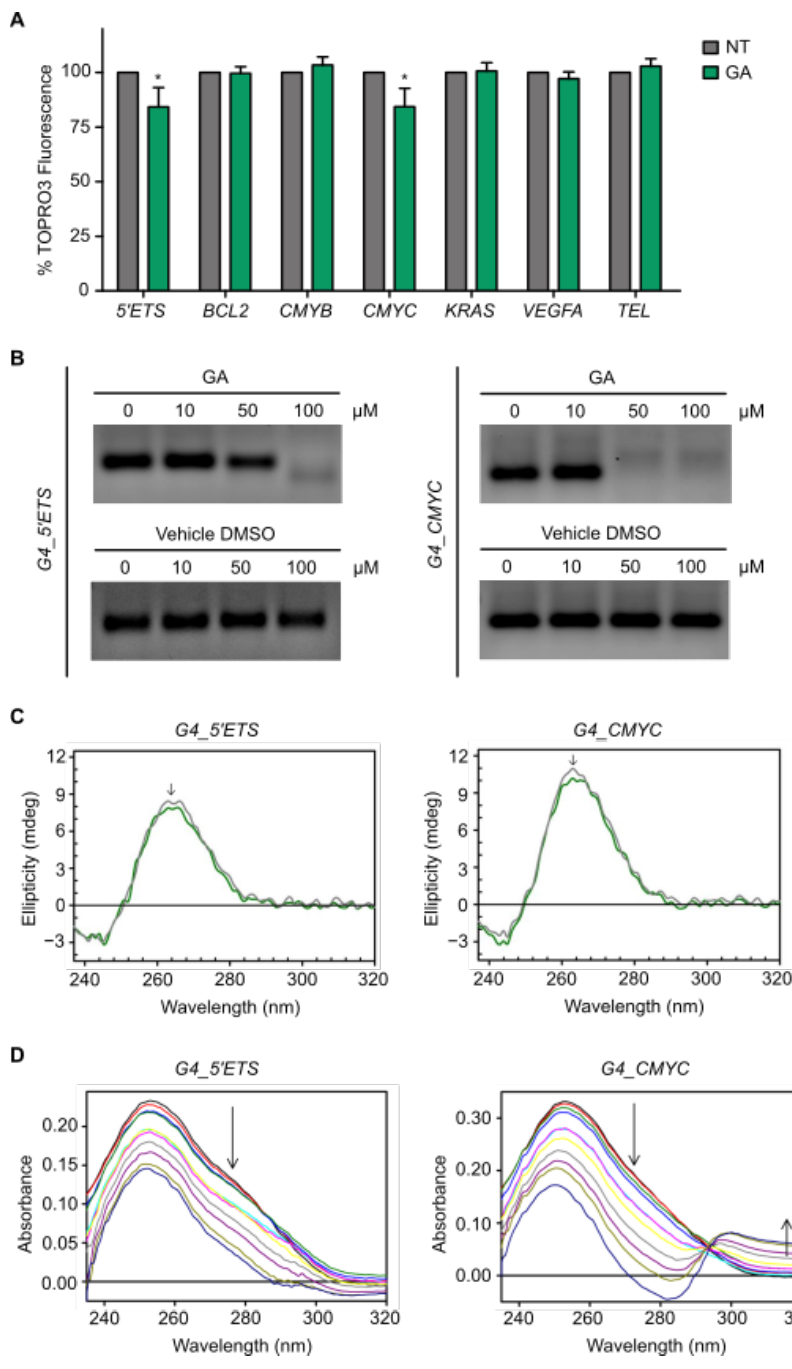
Figure 3. Gallic acid interacts with G4s in 5′ ETS and CMYC. ( A ) FID assay using different G4-containing oligonucleotides to determine the TOPRO3 fluorescence percentage in the absence (NT) or presence of GA 10 µM. Columns represent mean ± standard deviation. ( B ) Effect of increasing concentrations of GA or the corresponding vehicle DMSO on a PCR-stop assay including the G4-containing oligonucleotide of 5′ ETS and CMYC . ( C ) CD spectra obtained with the G4s formed by 5′ ETS and CMYC in the absence or presence of GA 100 µM. The arrows indicate the direction of movement of CD peaks upon addition of GA. ( D ) UV-vis spectra of the G4s formed by 5′ ETS and CMYC upon the addition of increments of GA 10 µM up to 100 µM as final concentration. The arrows indicate the direction in which the absorption peak moves after interaction of GA with G4. For all tests, p -values below 0.05 were considered significant and expressed as follows: * p < 0.05. Please see uncropped gels in Supplementary Figure S2.